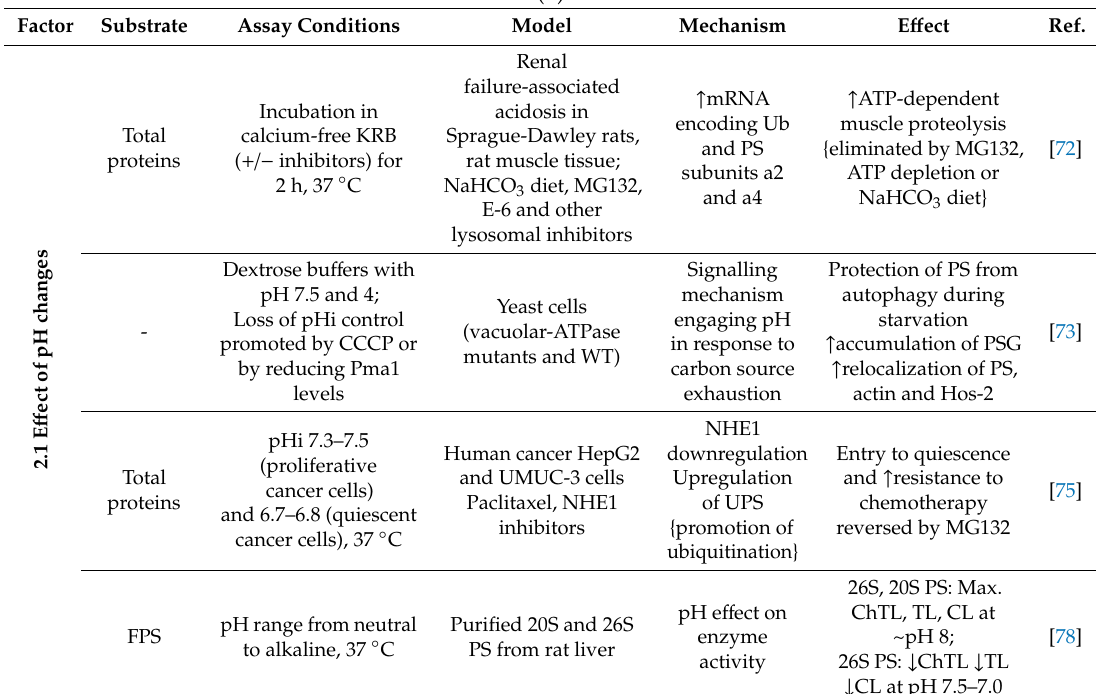
Table 1. ( a ) Effects of physico-chemical factors (stressors) on functionality of proteasome: Effect of pH. ( c ) Effects of physico-chemical factors (stressors) on functionality of proteasome: Effect of changes in